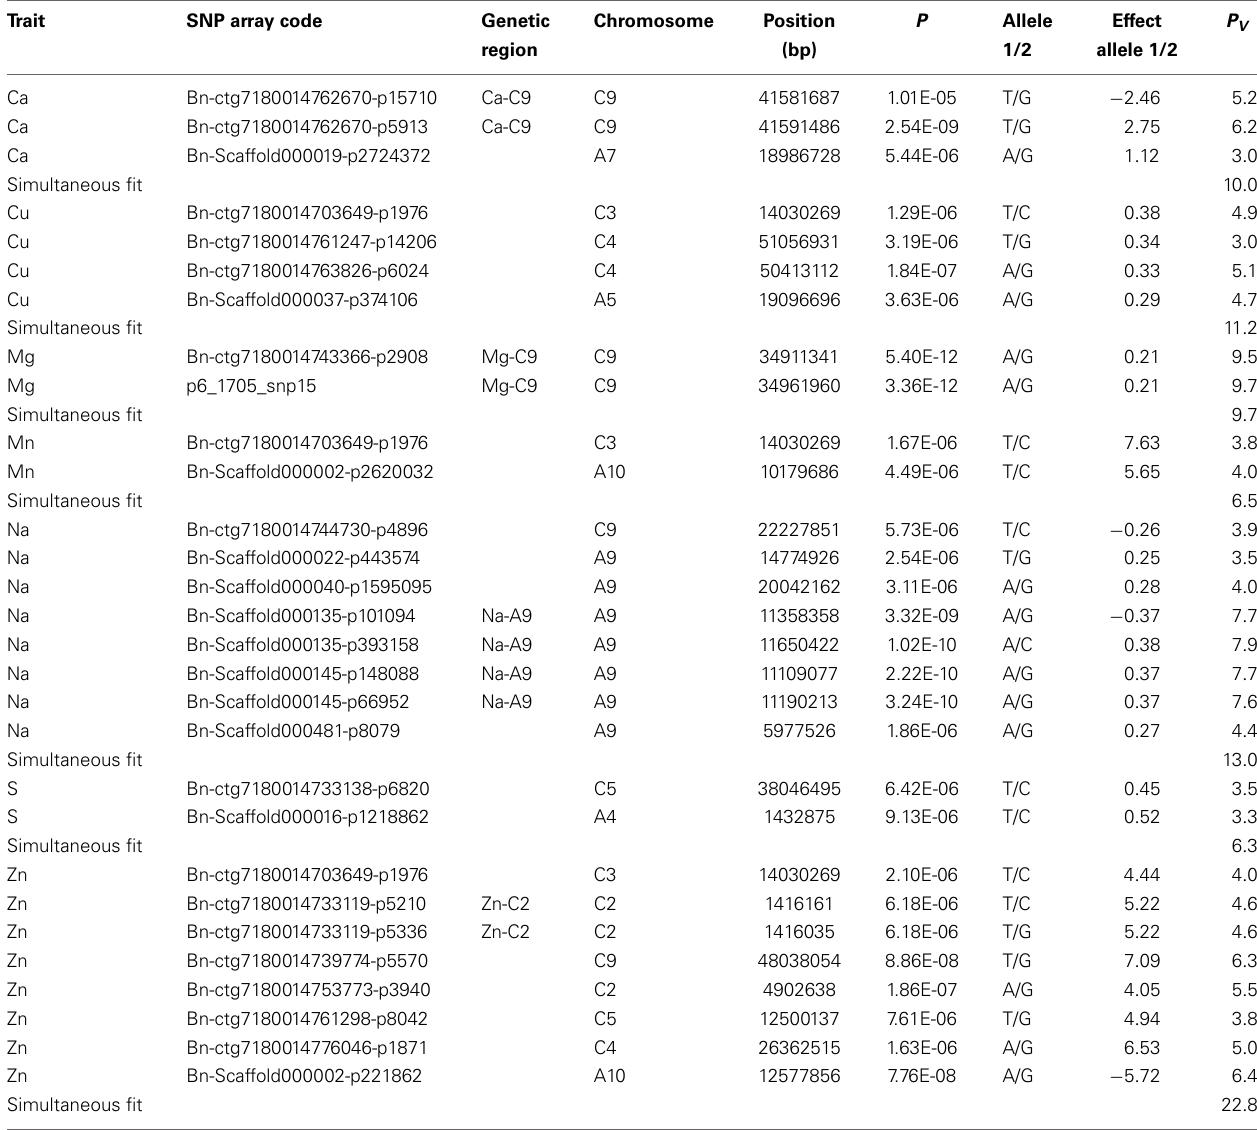
Table 3 | Twenty-nine significant ( α = 0.05) associations of 27 unique single nucleotide (SNP) markers with mineral concentrations after Bonferroni correction in a B. napus diversity